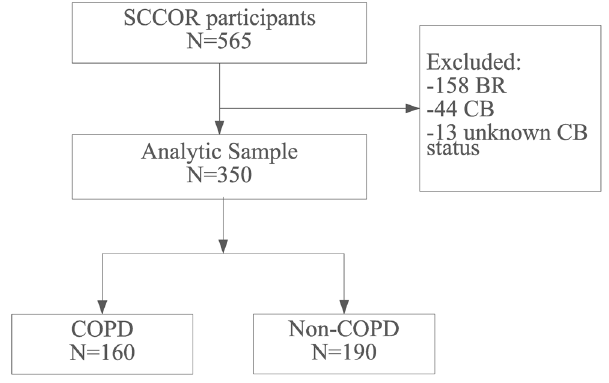
Figure 1. Flowchart illustrating how the final dataset analytic sample was obtained in which COPD by was defined by GOLD classification. (BR: subjects with bronchodilator response, and CB: subjects with chronic bronchitis).